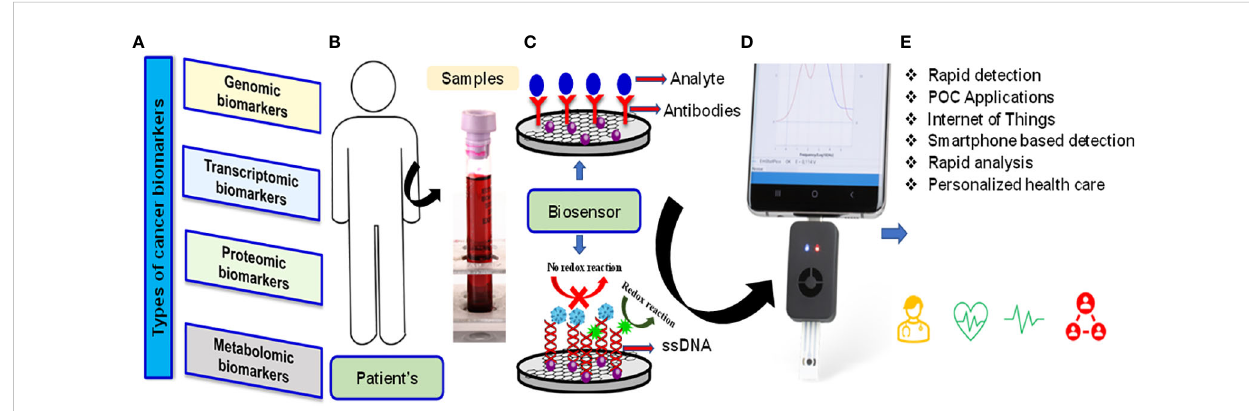
FIGURE 1 Types of cancer biomarkers (A) Patients samples (B) Schematic of biosensor-based diagnostics and procedure and mechanism of transducers (C) Smartphone based POC applications (D) Device support for AI and IoMT applications (E)